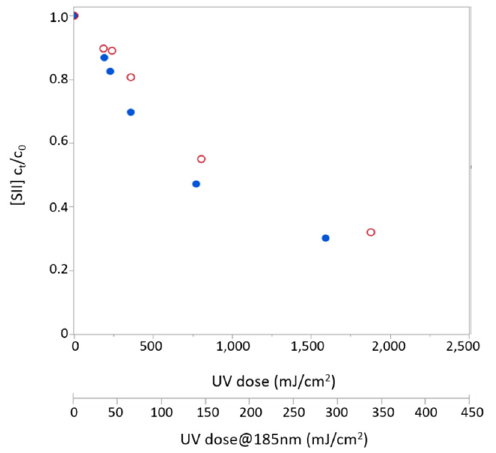
Figure 5. H 2 S removal from oxygen-free natural groundwater from Faran (concentrations normalized to initial concentration) using a 254 nm lamp (blank red circles) and a combined 254/185 nm lamp (solid blue circles) in different radiation doses.